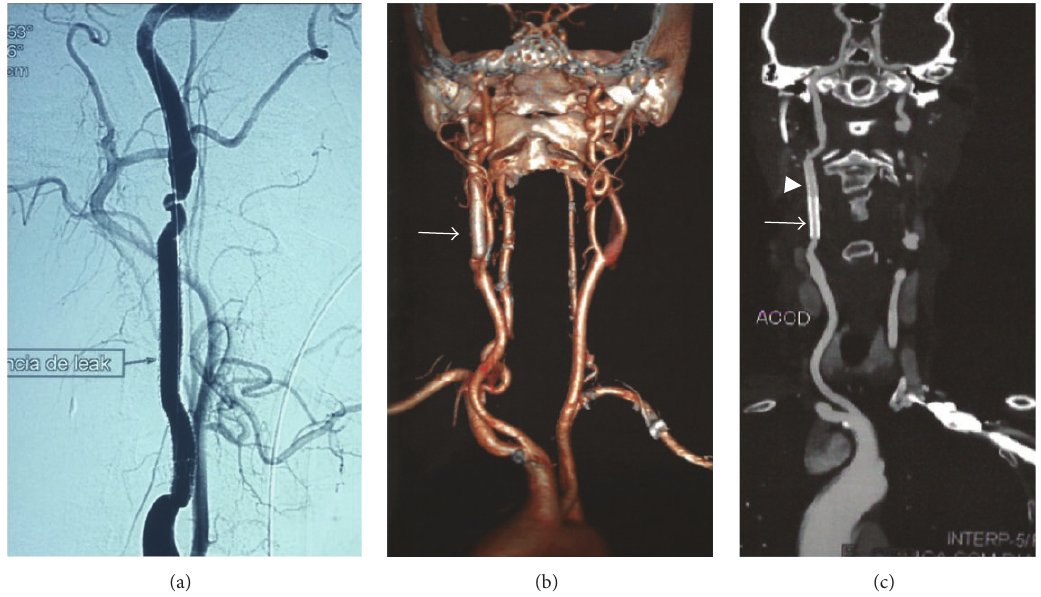
Figure 2: (a) Intraoperative angiography after second stent graft deployment, patent carotid, and leak absence; (b) one-year CT control, arrow points to the stent grafts, no signs of stents occlusion; (c) one-year CT control, arrow points to the first deployed stent grafts and arrow head points to the second stent